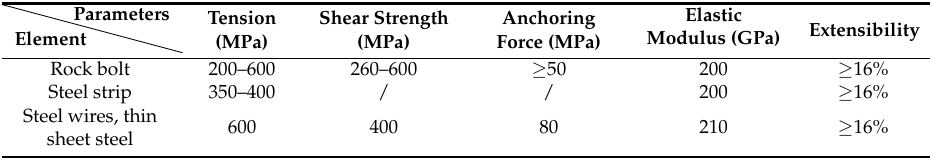
Table 3. Geometrical parameters of truss support structure.